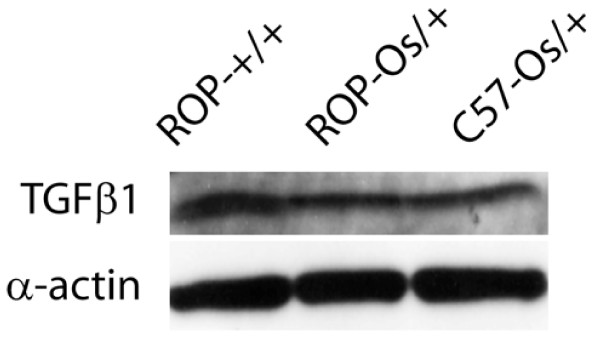
A representative western blot analysis of protein extracts from 6 weeks old ROP-Os/+ and C57-Os/+ kidneys probed with anti-TGFβ antibody. For comparison proteins from the WT ROP-+/+ kidneys are included. α-actin is used for loading control. Densitometry analysis of protein blots showed no difference in TGFβ protein level between ROP-Os/+ and C57-Os/+.